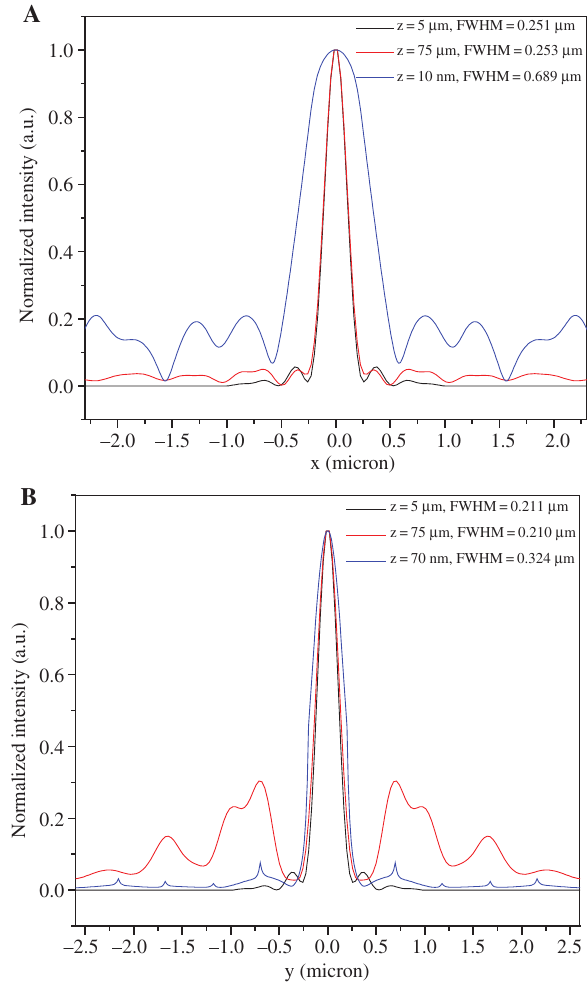
Figure 4: Two-dimensional E-field intensity profiles of the metalens along different propagation distances of z = 10 nm, 5 μ m and 75 μ m in both (A) x-axis and (B) y-axis.